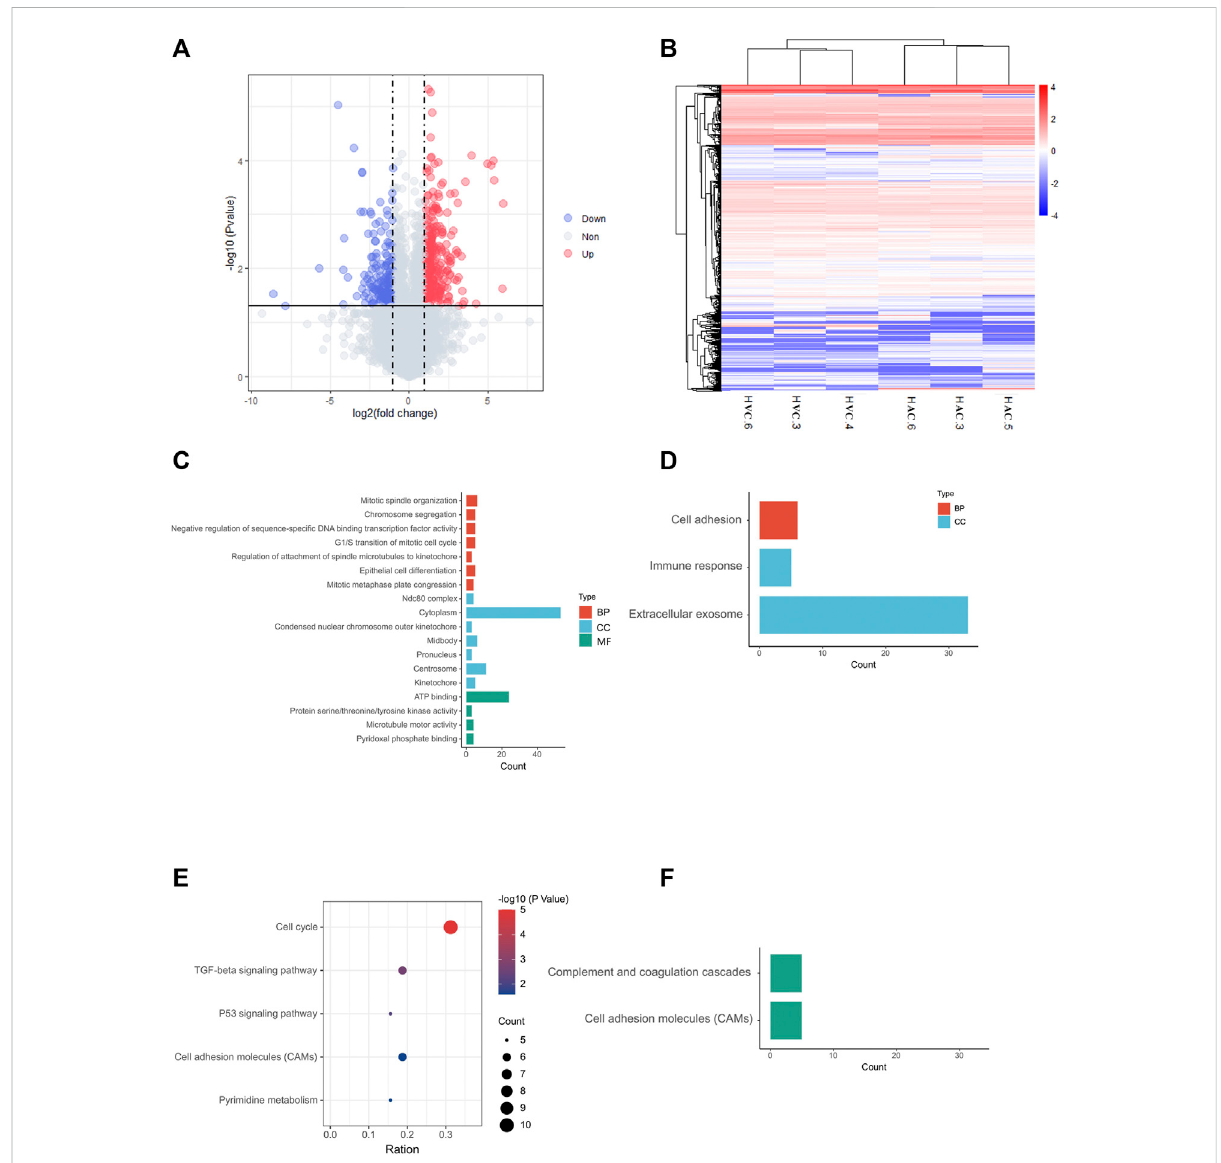
Results of RNA-seq and bioinformatic analysis. (A) Volcano map of DEGs in allantochorion (AC) virus chorion covering yolk sac (Vitelline- chorion, VC). The signi fi cantly upregulated and downregulated genes are shown as red and blue dots respectively. Gray dots indicate genes without signi fi cant differences. (B) Hierarchical cluster analysis of DEGs. Overall FPKM hierarchical clustering diagram is based on the log10 (FPKM +0.05) value for the normalization of the conversion (scale number) and clustering. Red represents high-expressed genes, and blue represents